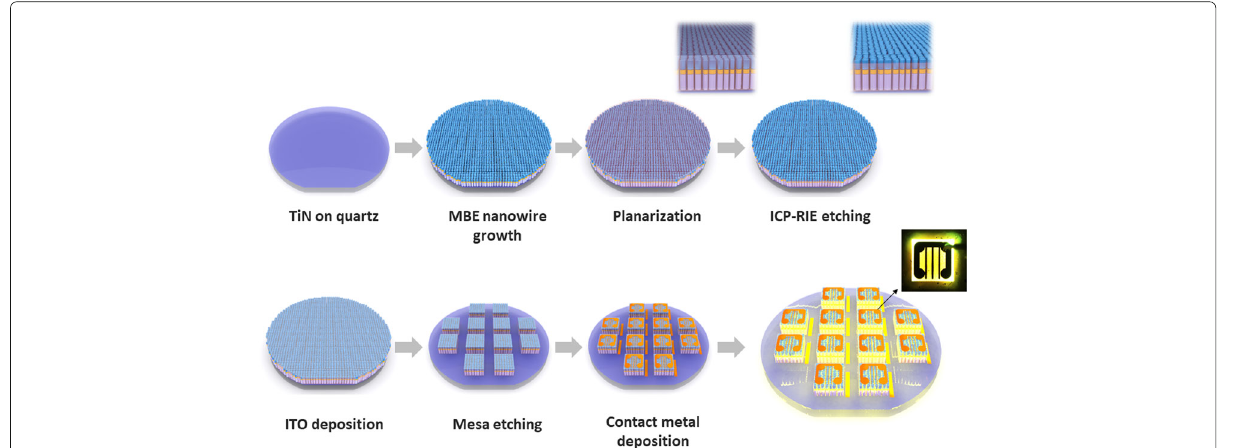
Fig. 4 Fabrication steps for the nanowires on quartz